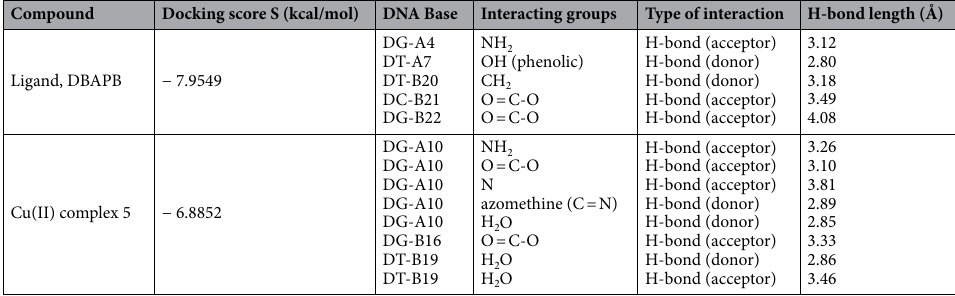
Table 9. Results of docking interactions to DNA of the ligand, DBAPB, and its Cu(II) complex 5.